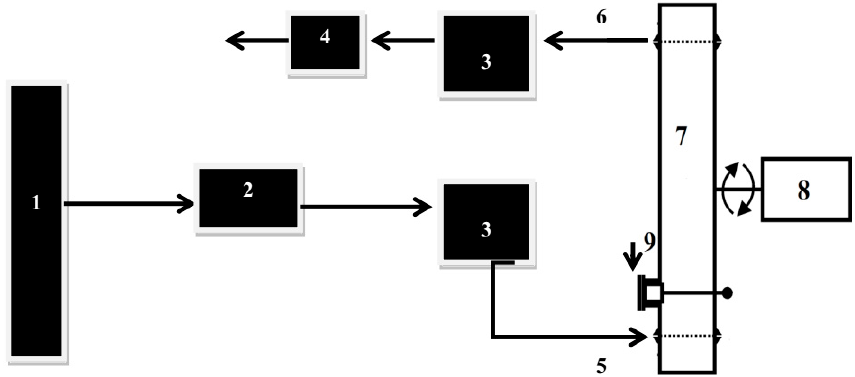
Figure 1. Ozone treatment system in dynamic bed for gaseous phase used for laboratory purposes;